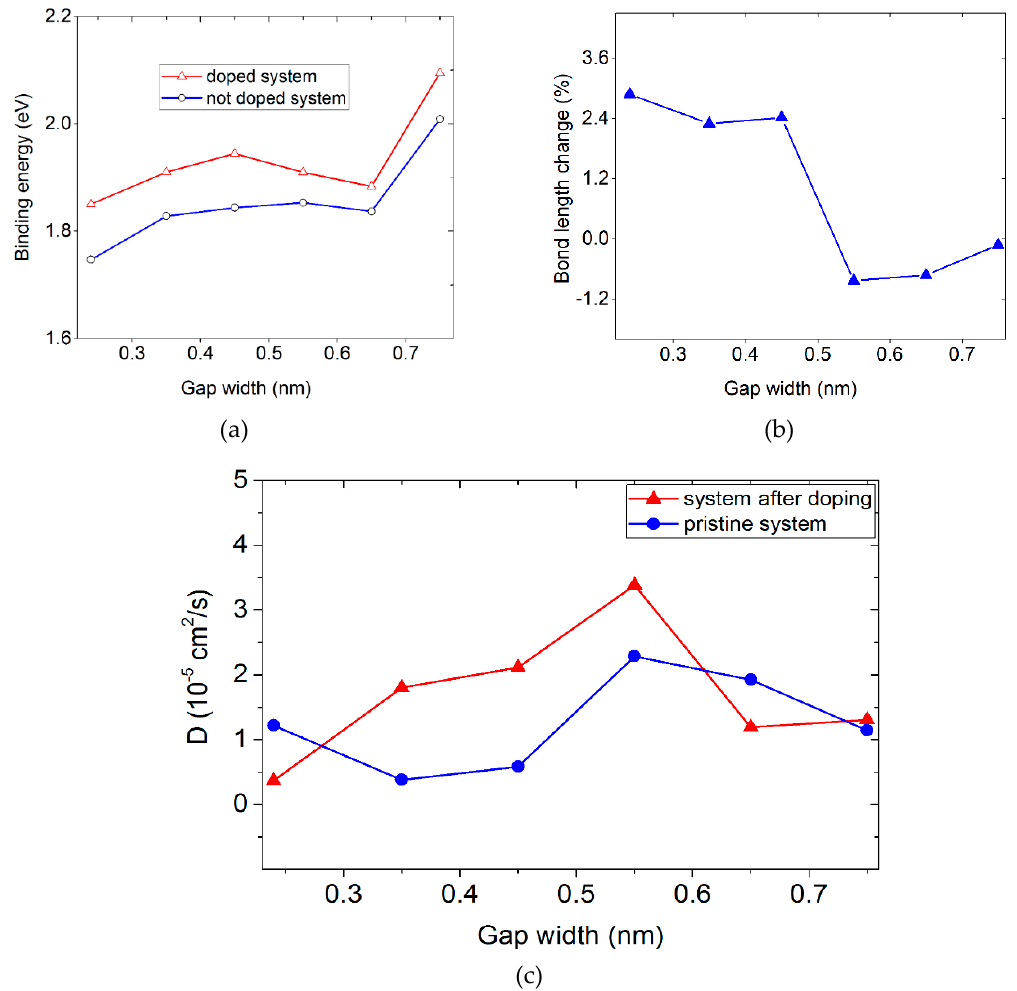
Figure 7. ( a ) Binding energy, E b , of Li as a function of channel gap width for undoped and doped systems; ( b ) change in the Si–P bond length during the filling of a silicene channel with phosphorus-doped walls as a function of the channel gap; ( c ) coe ffi cient of the self-di ff usion of lithium atoms in the silicene channel with undoped and phosphorus-doped